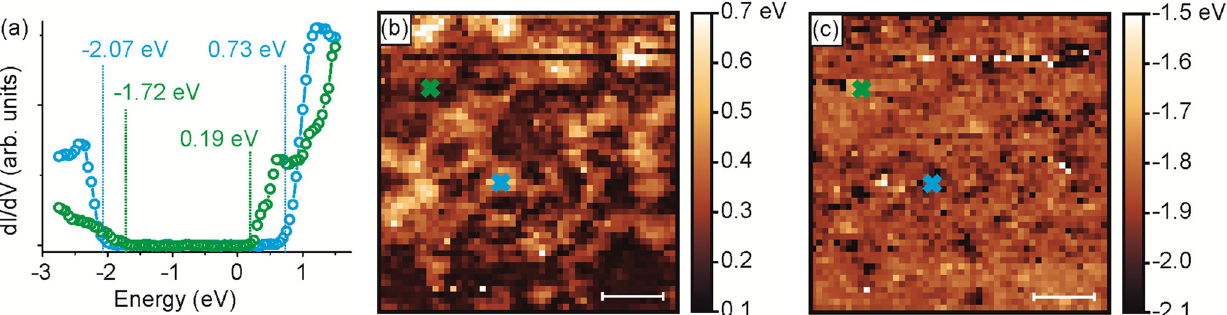
Fig. 3 Visualization of band structure spatial fl uctuations by STS. a STS data obtained at two different positions on MoS 2 /hBN/Pt(111) showing the onset values determined from the trapped states below the CB and above the VB. STS maps (50 nm × 50 nm) visualizing the spatial distribution of the band structure inhomogeneity are shown in ( b ) and ( c ), respectively (scale bar: 10 nm). The positions where the blue and green curves shown in a were obtained are marked with crosses. The corresponding topography map is provided in Supplementary Fig. in good agreement with the experimental data (dotted line in Fig. 2a) giving the values of U 0 ffi 0 : 18eV and n 0 ffi 2 : 7 ´ 10 18 m (cid:1) 2 .